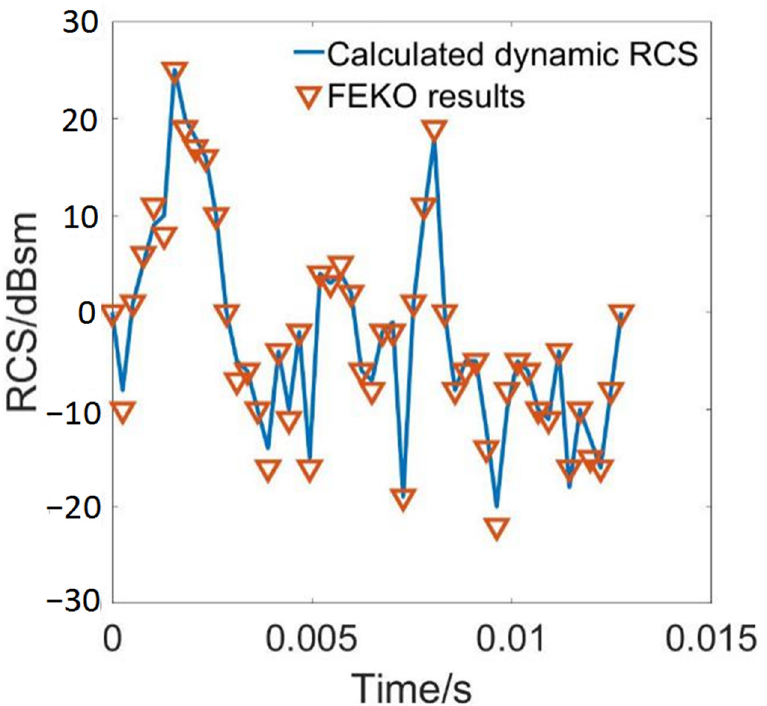
Figure 4. Comparison of dynamic RCS between the calculated result and FEKO result of a tilt-rotor model.